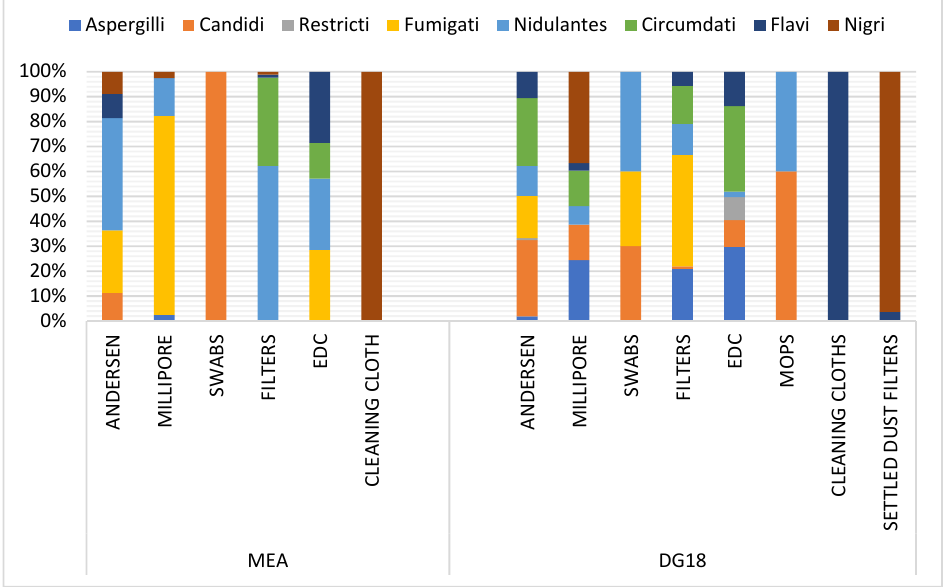
Figure 4. Distribution of Aspergillus sections per matrice in MEA (Malt Extract Agar) and DG18 (Dichloran–Glycerol Agar).